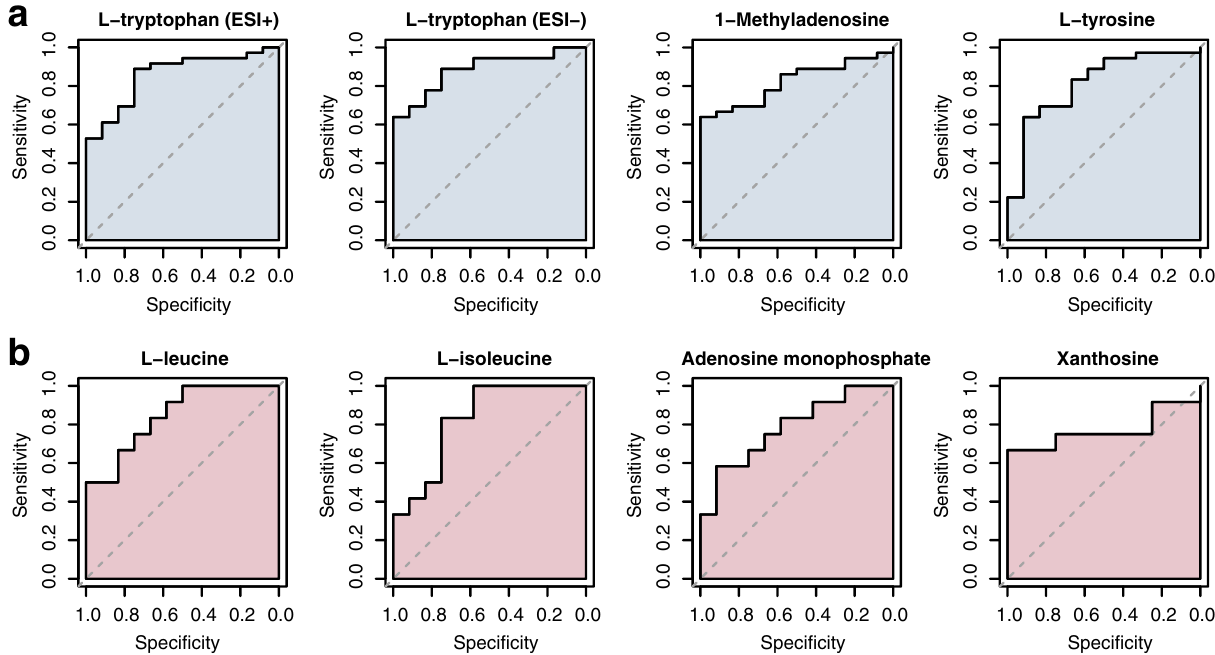
Figure 5. ROC analyses of significant metabolites for healthy (n = 12) versus all SSc (n = 36) ( a ) and stable (n = 12) versus progressive (n = 12) SSc-ILD ( b ). AUC area under the curve. Brackets show confidence Amino acid profiles discriminate between groups and correlate with changes in lung function and prognostic scores. To select the best discriminators between two groups, we performed ROC curve analysis for the previously identified candidate serum metabolites. l-Tryptophan, detected in both ESI+ and ESI− modes, best differentiated between healthy individuals and SSc patients (AUC 0.859, 95% CI 0.745–0.973; AUC 0.884, 95% CI 0.788–0.981), followed by 1-methyl-adenosine (AUC 0.822, 95% CI 0.705–0.939) and l-tyrosine (AUC 0.812, 95% CI 0.667–0.958) (Fig. 5a). In the group of ILD patients, l-leucine and l-isoleucine performed best to distinguish progressing from sta- ble SSc-ILD patients (AUC 0.847, 95% CI 0.695–1.00; AUC 0.826, 95% CI 0.656–0.997), followed by adenosine monophosphate (AUC 0.785, 95% CI 0.598–0.971), and xanthosine (AUC 0.771, 95% CI 0.551–0.990) (Fig. 5b). No significant performance of metabolites in separation of non-ILD SSc and SSc-ILD patients was observed. Notably, in patients with SSc-ILD, both, l-leucine and xanthosine negatively correlated with changes in the lung function parameter FVC% predicted (r = − 0.48 and − 0.51; p = 0.016 and 0.011, respectively), while xan- thosine also negatively correlated with changes in DLco% predicted (r = − 0.58; p = 0.0038) as well as with the GAP index (r = 0.67, p = 0.0005) (Fig. 6). The correlations with changes in absolute values of FVC and DLco% predicted are shown in Supplementary Fig. S1a,b. Validation of higher values of the BCAAs l-leucine and l-isoleucine in progressive SSc-ILD compared to stable disease with the use of an enzymatic assay resulted in similar results as LC–MS/MS, with significantly higher values detected in progressive patients (mean = 286.5 and 235.5 µM, for progressive and stable patients, respectively; p = 0.005) (Fig. 7a). In ROC analysis (AUC 0.818, 95% CI 0.631–1.032), a cut-off value of 250.3 µM separated stable from progressive patients with a sensitivity of 72.7% and a specificity of 83.3% (Fig. 7b). Fur- thermore, BCAA levels negatively correlated with changes in FVC (r = − 0.55; p = 0.0063) and DLco% predicted (r = − 0.56; p = 0.0064) and positively with the GAP index (r = 0.66, p = 0.0005) (Fig. 7c–e). The correlations with changes in absolute values of FVC and DLco% predicted are shown in Supplementary Fig. S1c. For external validation, we assessed BCAA levels in an independent, prospectively followed cohort of SSc- ILD patients from Paris. Herein, we found a similar trend towards higher BCAA levels in patients with future progression of ILD as compared with patients, who remained stable during follow-up (mean = 311.8 ± 26.5 and 289.6 ± 49.4 µM, respectively; p = 0.26). In ROC analysis, BCAA levels correlated negatively with DLco% pre- dicted (r = − 0.38, p = 0.027), and positively with the mortality-predicting GAP index (r = 0.39, p = 0.022). The results are shown in Supplementary Fig. S2, for details including patients’ characteristics refer to data supplement. In order to assess whether elevated BCAA levels specifically reflected fibrotic and/or pulmonary processes, we measured BCAA serum levels in 29 patients with non-fibrotic, primary myositis 26 without concomitant ILD. Interestingly, BCAA levels significantly correlated with disease activity (Spearman’s rho = 0.52, p = 0.0037). Patients with CK levels exceeding the defined upper limit of normal (170 U/l) had significantly higher BCAA levels than patients with low CK levels (mean = 309.5 ± 88.2 and 253.4 ± 41.6 U/l for active and inactive disease, respectively; p = 0.032). No correlation with systemic inflammation, measured by CRP as a surrogate marker, was observed (Pearson’s r = − 0.15, p = 0.46). All results are visualized in Supplementary Fig. S3, for details including patients’ characteristics refer to data supplement.